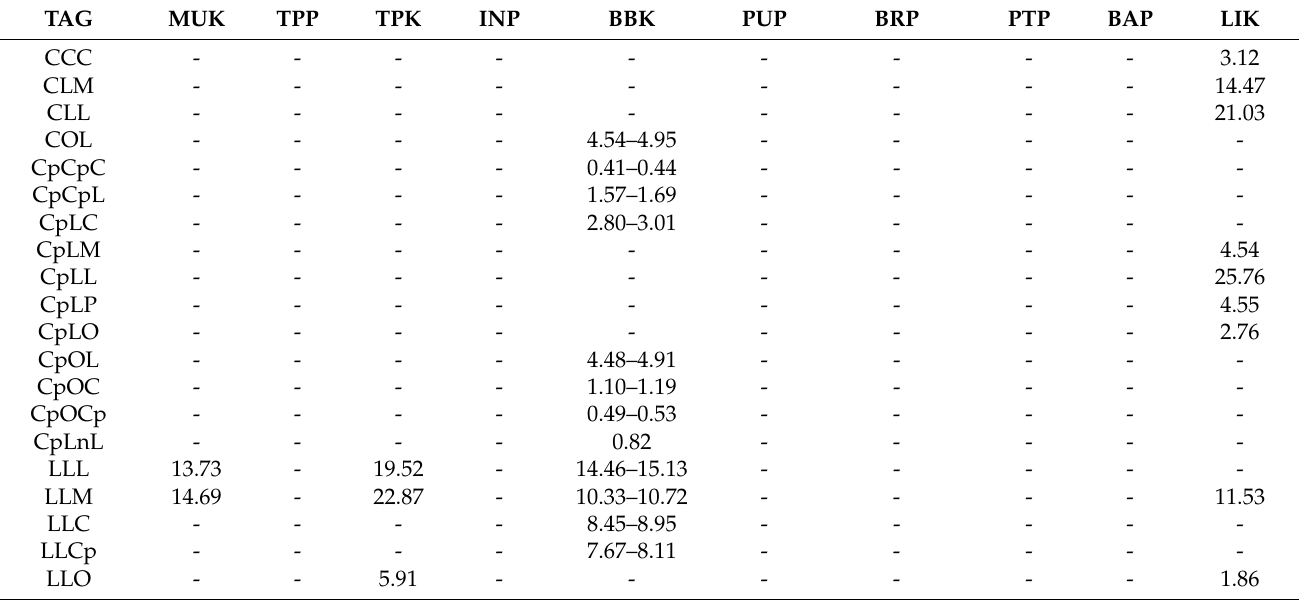
Table 4. Triacylglycerol (TAG) composition* of different Arecaceae palm fruit